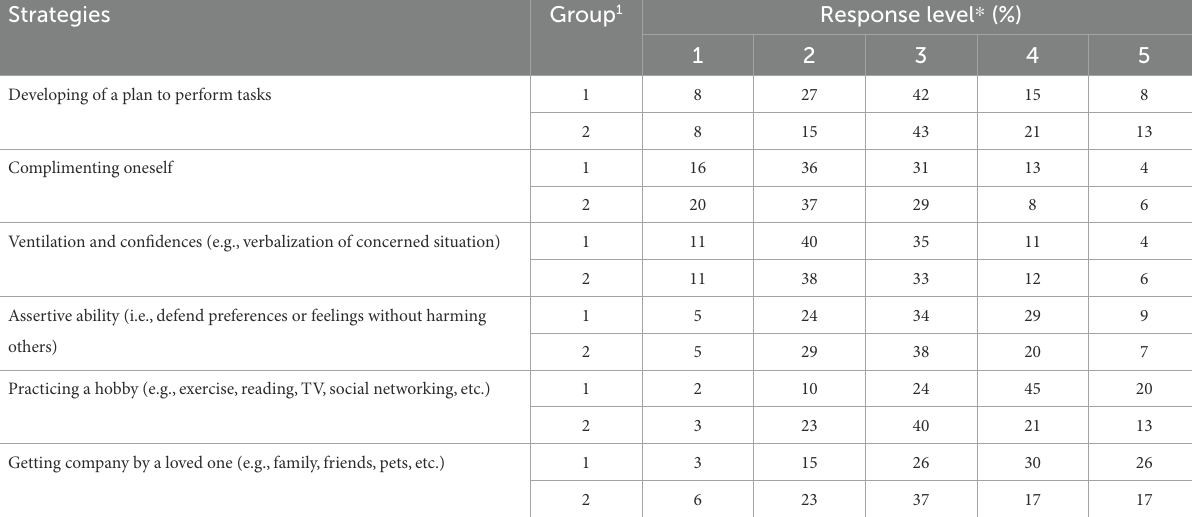
TABLE 6 Comparison of coping strategies by response level between the two stress groups among medical students ( n = 728).